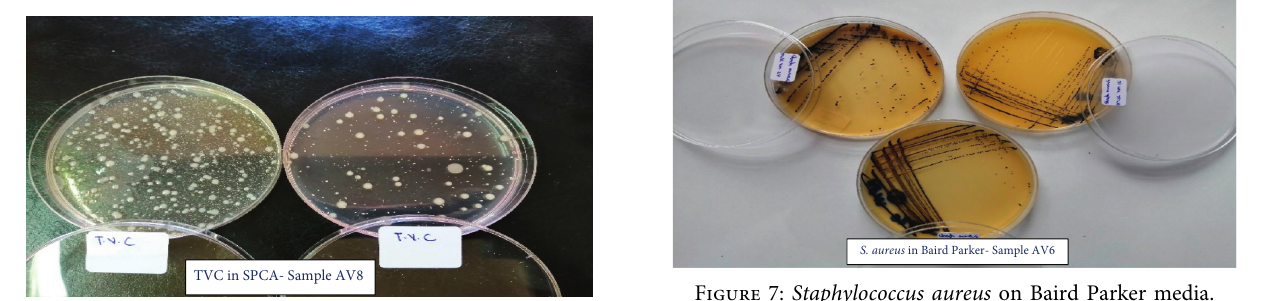
Figure 5: Total viable count colonies on standard plate count agar (SPCA).